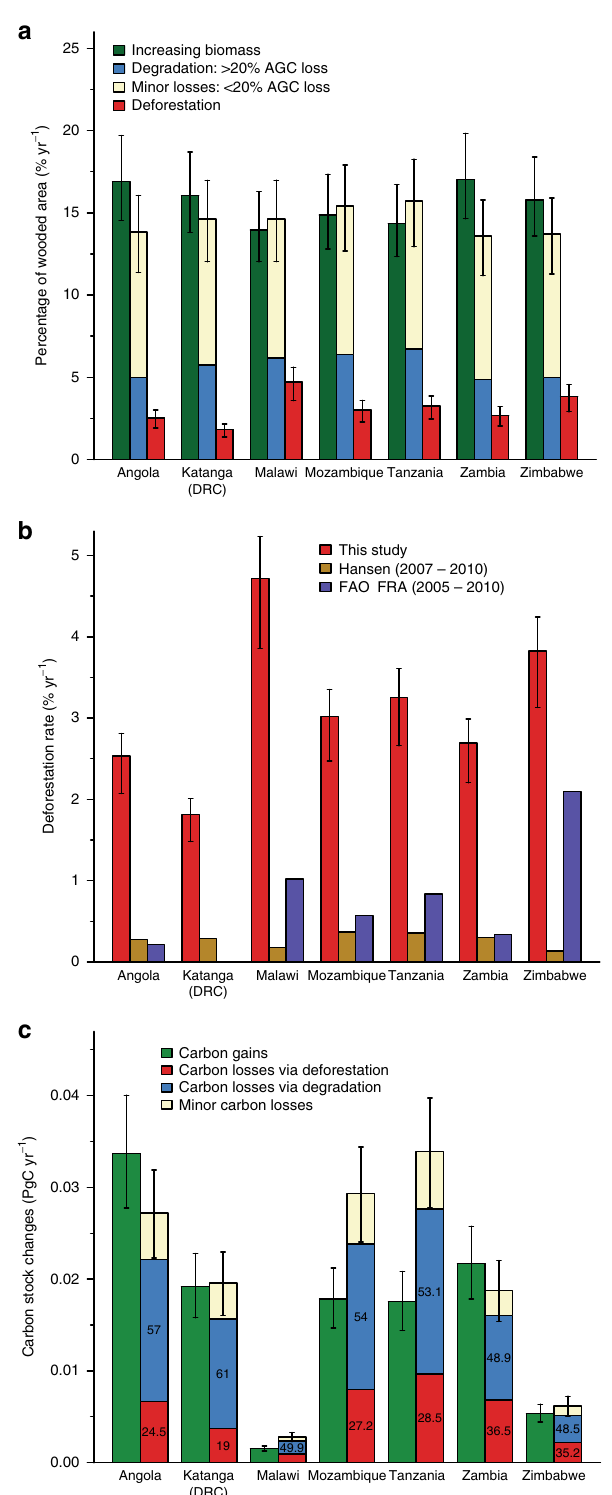
Fig. 4 Woodland area and carbon stock changes separated by nation/ region. a Percentage of the wooded area in 2007 affected by deforestation, degradation, minor losses and (re)growth. b Comparison between existing estimates of deforestation rates and this study. c Carbon stock changes due to deforestation, degradation and (re)growth, with the values is the losses bar showing the percentage contribution of deforestation and degradation to the total carbon losses . Error bars show the 95% con fi dence intervals (CIs) and represent for the total error on each